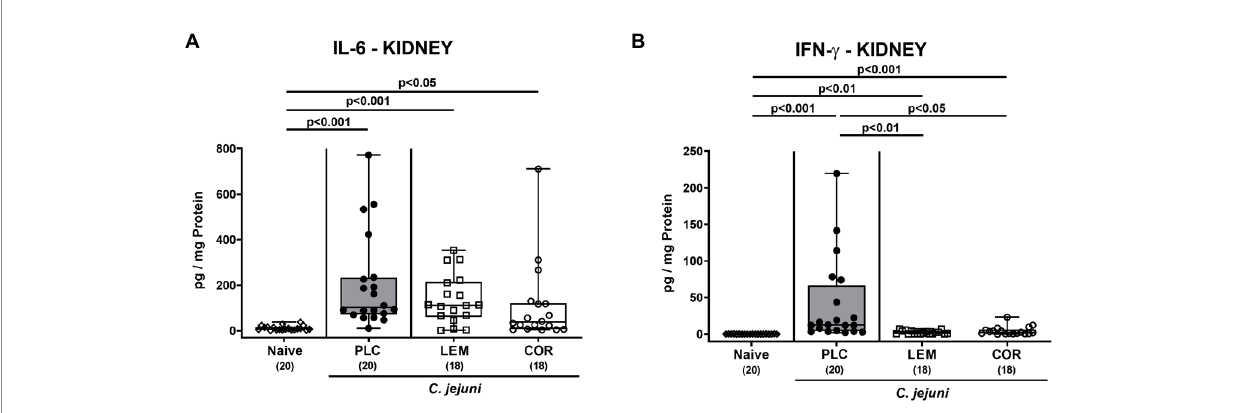
FIGURE 6 Pro-inflammatory cytokine secretion in the kidneys following prophylactic oral application of lemon or coriander essential oil to C. jejuni infected mice. SAB IL-10 − / − mice were subjected to prophylactic lemon (LEM; white squares) or coriander (COR; white circles) essential oil via the drinking water ( ad libitum ) starting seven days prior infection. Placebo (PLC; black circles) control animals received tap water only. On days 0 and 1, mice were then perorally infected with C. jejuni strain 81–176 by gavage. On day 6 post-infection, (A) IL-6 and (B) IFN- γ concentrations were measured in ex vivo biopsies derived from the kidneys. Naive mice were included as non-infected, untreated controls (white diamonds). Box plots (indicating the 25th and 75th percentiles), whiskers (indicating the minimum and maximum values), medians (black bar inside box) and numbers of analyzed mice (in parentheses) are shown. Significance levels ( p values) were calculated by the Kruskal–Wallis test with Dunn’s post-correction using pooled data from four independent experiments.